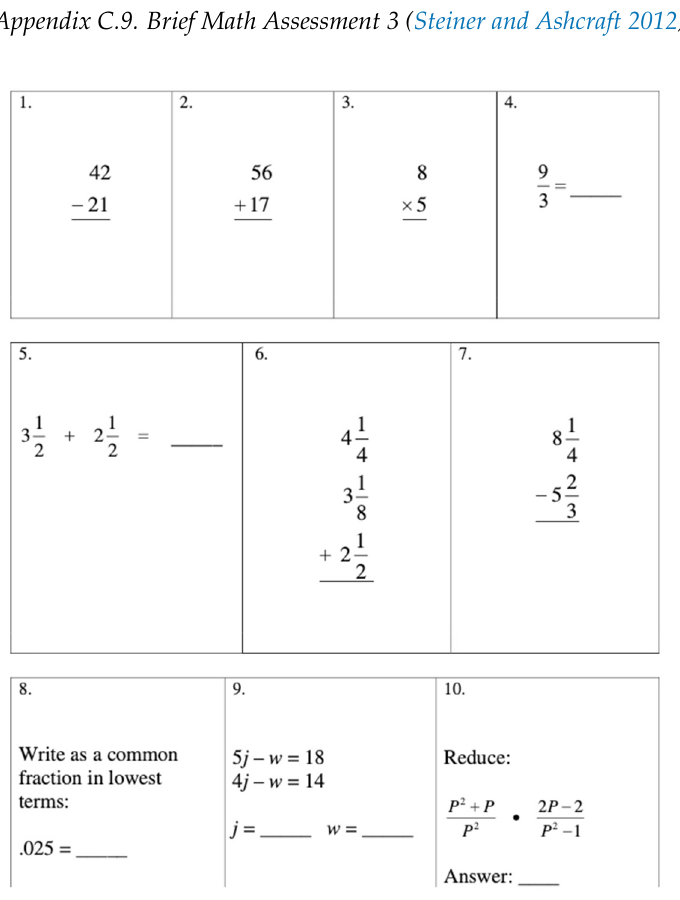
Figure A1. Items from the BMA-3.